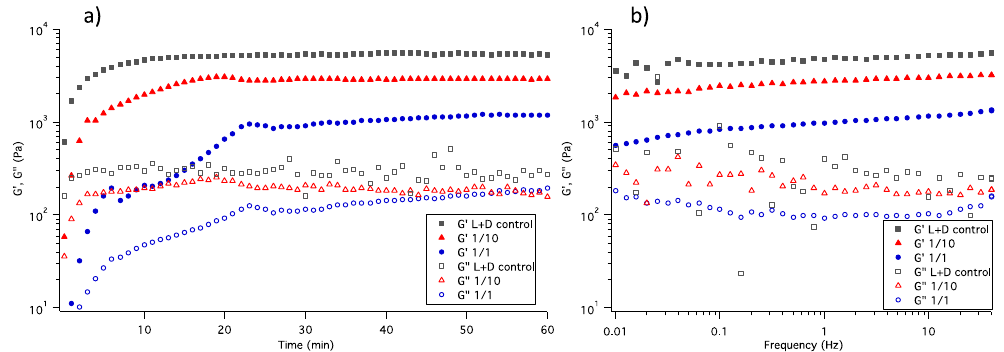
Figure 6. Rheological properties with ( a ) time and ( b ) frequency plots for the stereocomplex hydrogels